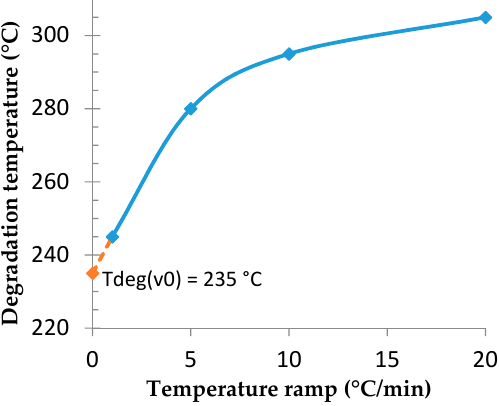
Figure 9. Influence of temperature ramp on the degradation temperature of compressed microspheres, by TGA, under air.